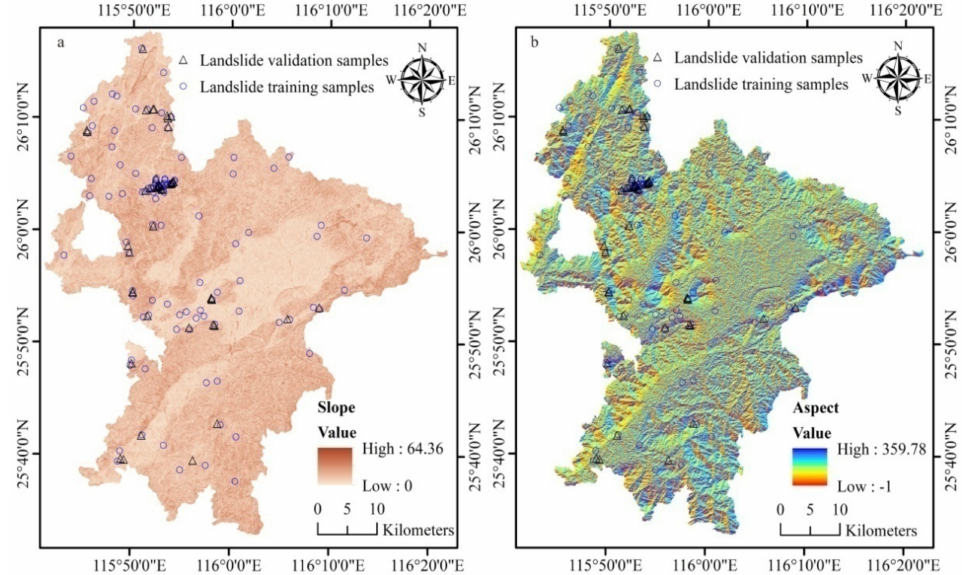
Figure 5. Geo-Environmental factors 3: ( a ) slope and ( b )